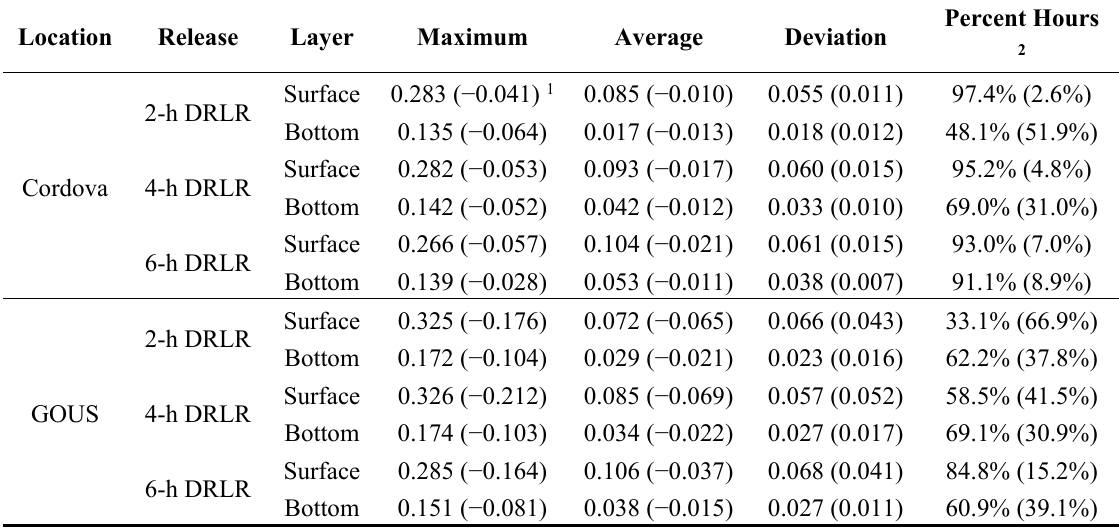
Table 2. Statistical information of simulated velocities (m/s) at Cordova and GOUS. Location Release Layer Maximum Average